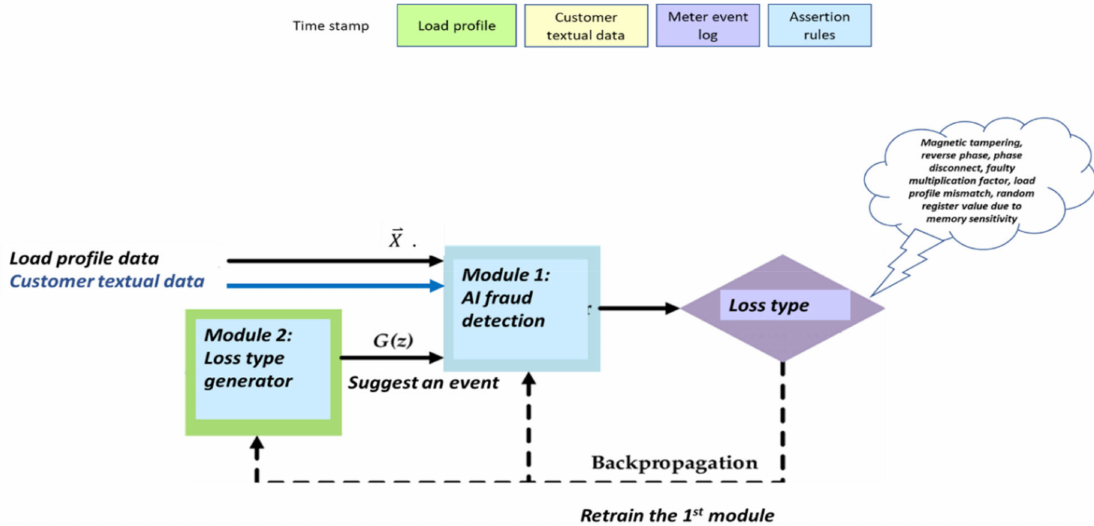
Figure 5. High-level schematic of the TNT loss detection system—it is the same as the generative adversary modules scheme but only when the retraining module is